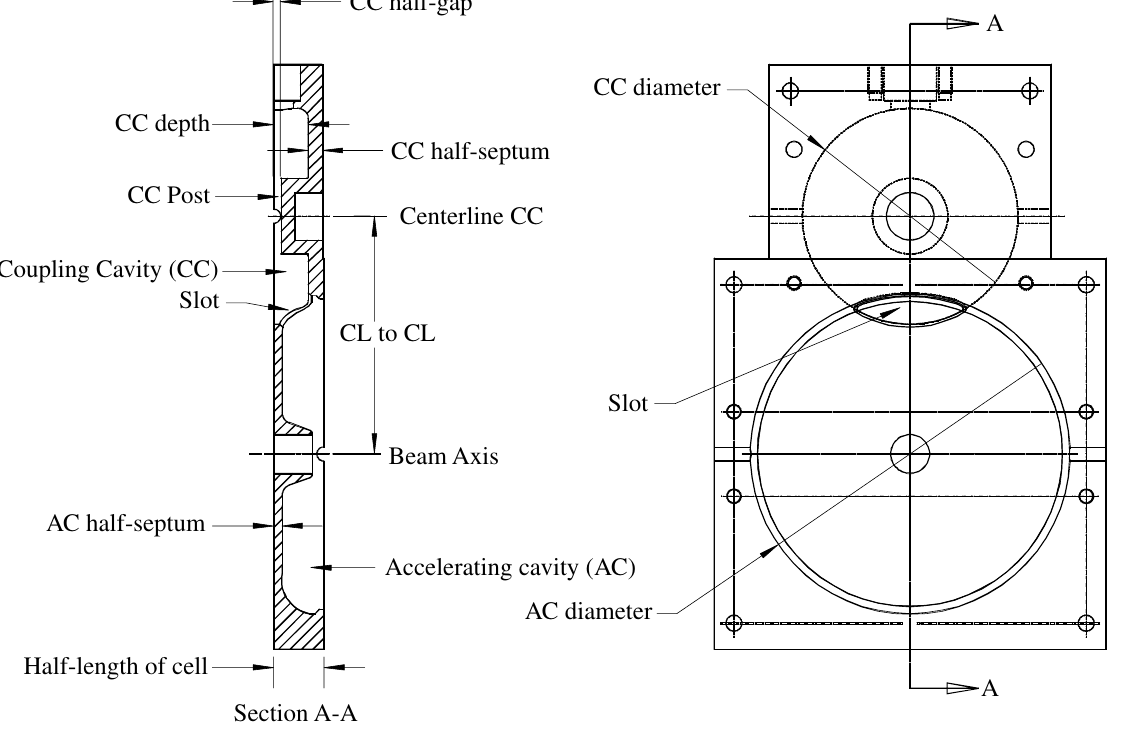
FIG. 3. Cavity plates with two